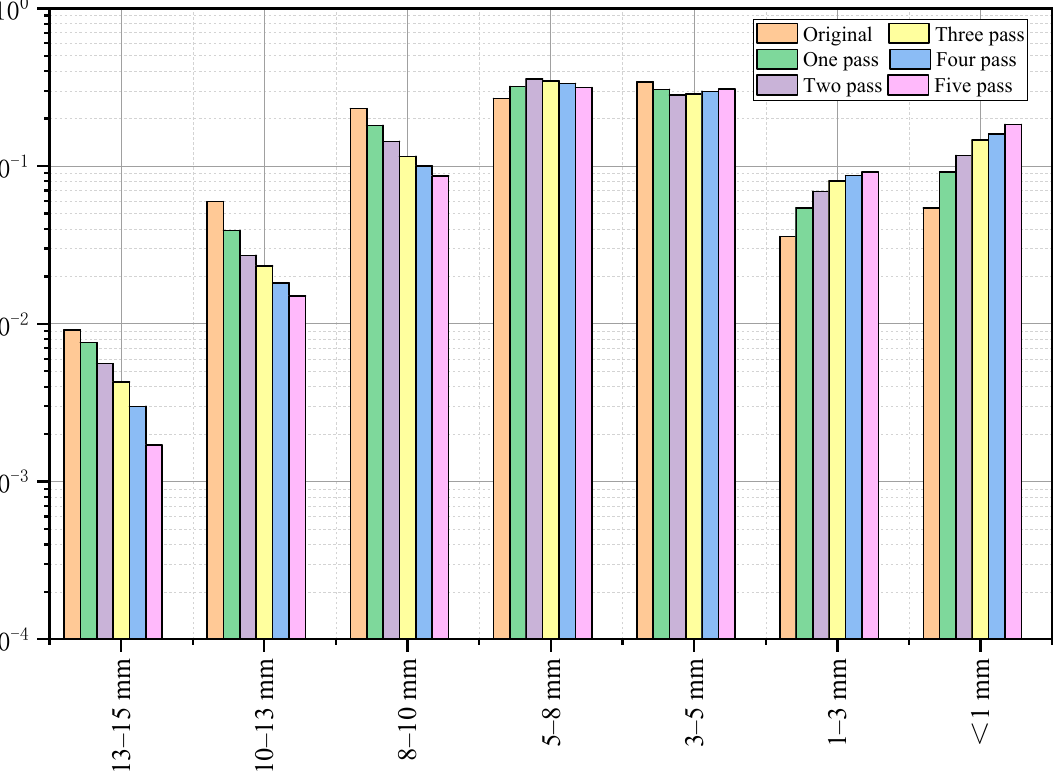
Figure 9. Comparison of PSD of polymetallic nodules with different passes (10 0 means that the percentage of particle size class is 100%, and 10 − 4 means that the percentage of particle size class is 0.01%).